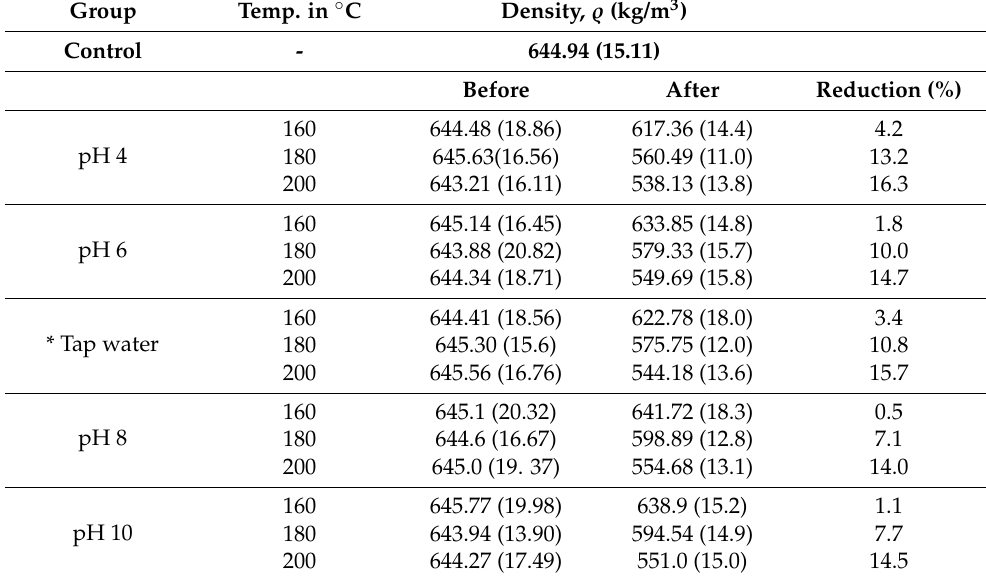
Table 4. Density of rubberwood before and after hydrothermal treatment at different temperatures and using buffered media. Group Temp. in ◦ C Density, (cid:36) (kg/m 3 ) Control - 644.94 (15.11) Before